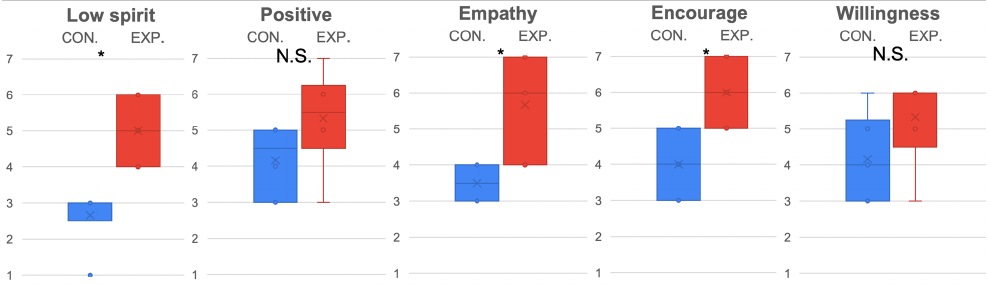
Figure 5. Emotion expression and evaluation of ERICA evaluated by female subjects. * indicates the found significant difference, while N.S. indicates there is no significant